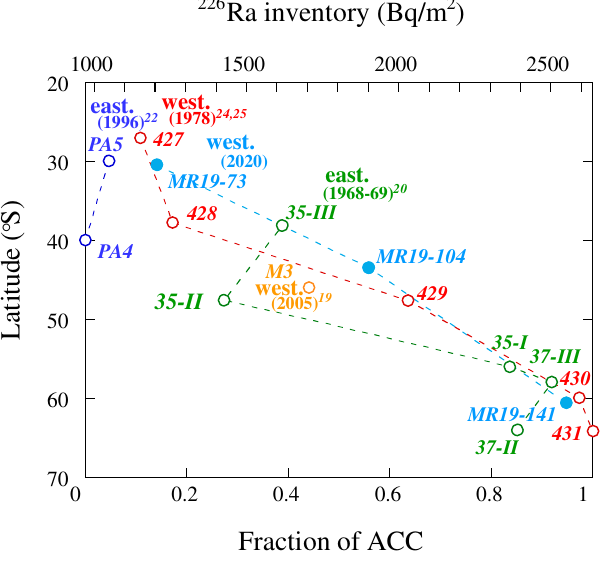
Figure 7. Inventories of 226 Ra concentrations (depth of 0–800 m) and fractions of the ACC (1.0 at site 431) versus latitude, compared with data from previous studies recorded in the western 19,24,25 and eastern Sections 20,22 of the subantarctic Indian and Southern Oceans over the last 50